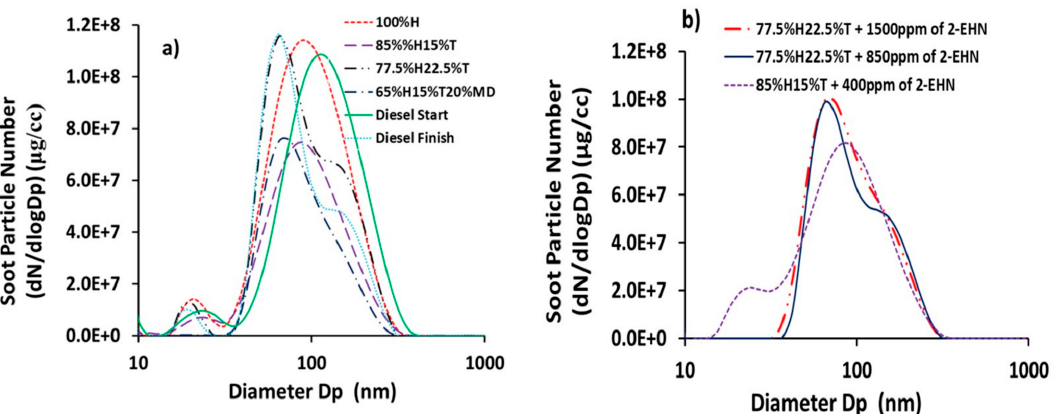
Figure 2. Distribution of soot particle number concentrations (dN / dLogDp (cm − 3 )) for the fuel blends and reference diesel fuel ( a ) without 2-ethylhexylnitrate (2-EHN) ( b ) with 2-EHN. Table 5. Filter soot mass measurements without 2-EHN ignition improver.